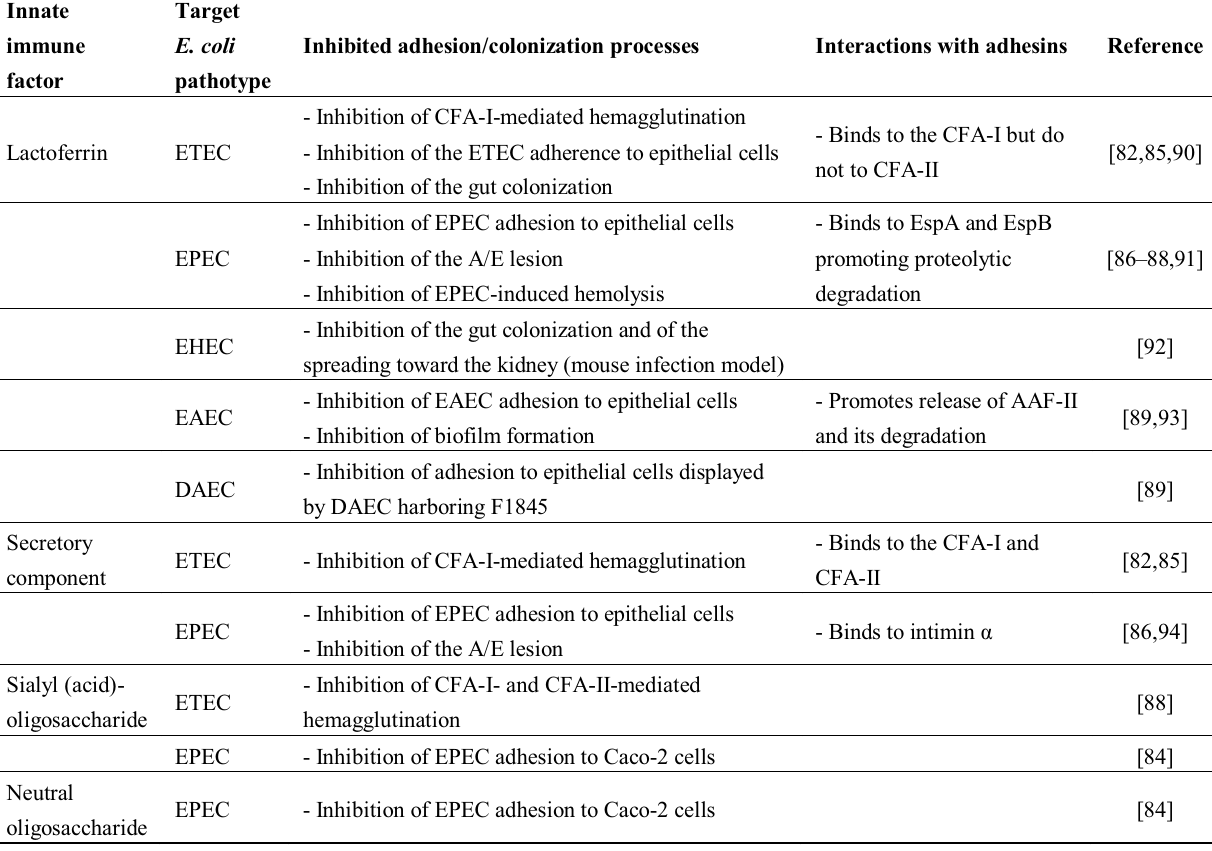
Abbreviations: A/E lesion (cid:178) attachment-and-effacement lesion; F1845 (cid:178) prototype Afa/Dr fimbria; CFA (cid:178) colonization factor antigen of